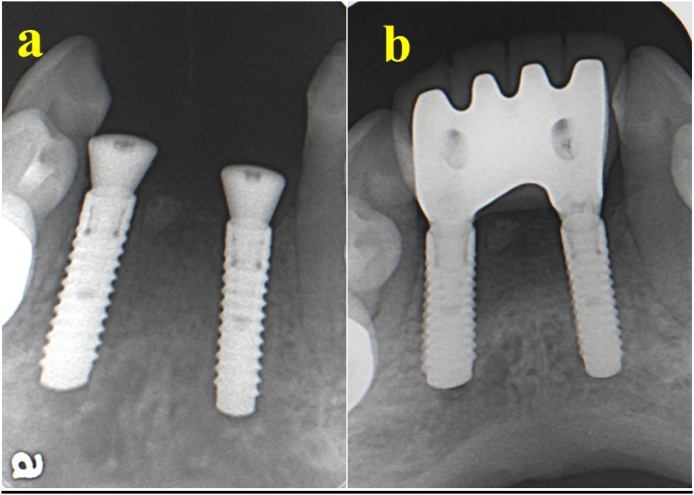
(A) Two implants inserted to replace missing lower anterior teeth. (B) 12 months after loading.